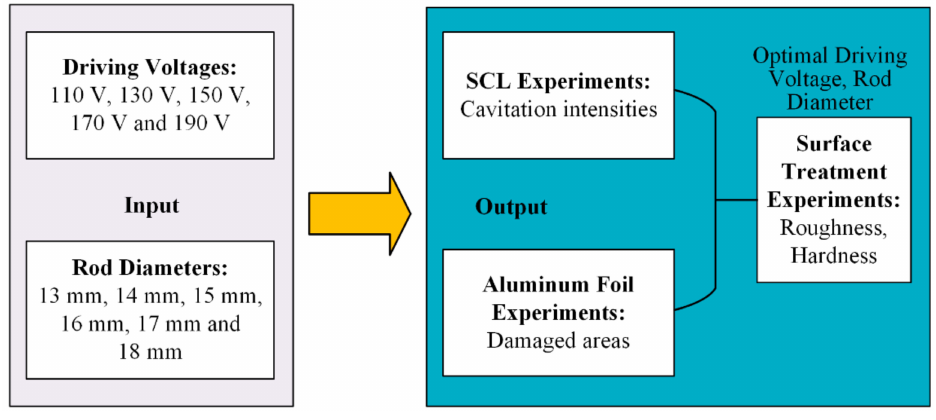
Figure 3. The block scheme for cavitation